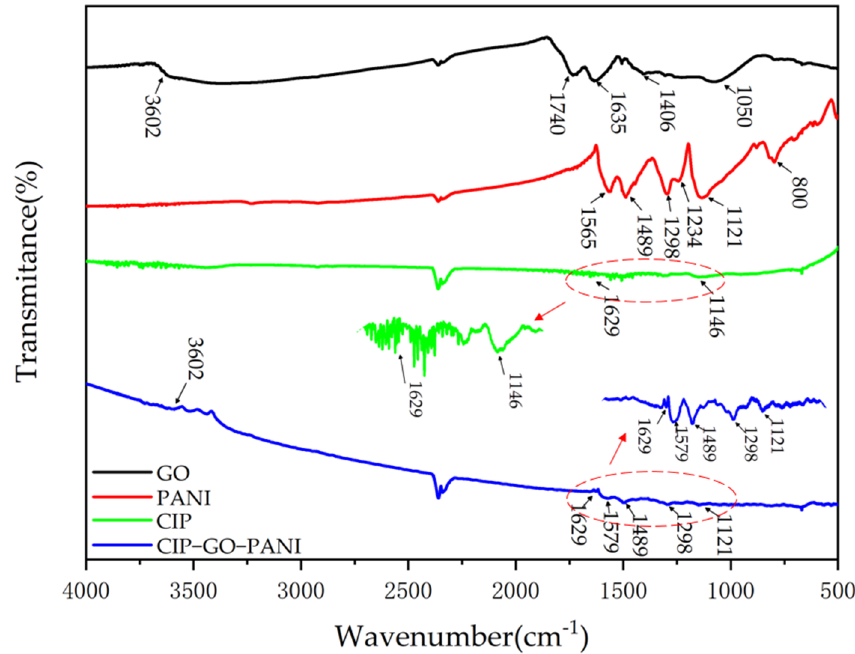
Figure 6. FT − IR images of GO, PANI, CIP and CIP − GO − PANI nanocomposites. Figure 6. FT-IR images of GO, PANI, CIP and CIP-GO-PANI